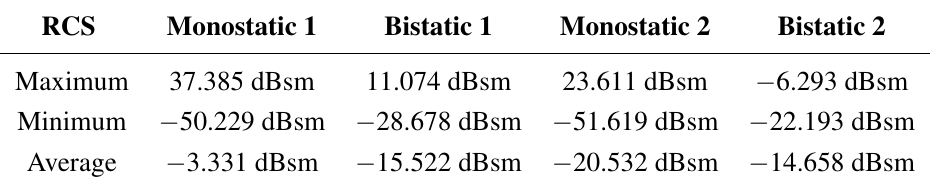
Figure 12. Bistatic RCS averaged along the incidence direction azimuth, φ case study; ( b ) Bistatic 2 case study. Table 1. Bistatic RCS simulations